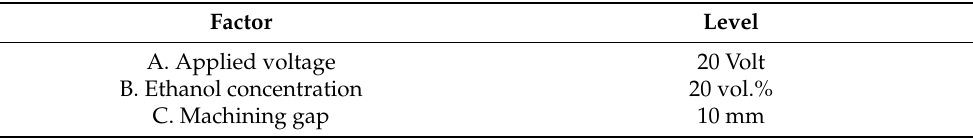
Table 9. Optimal conditions for the EP